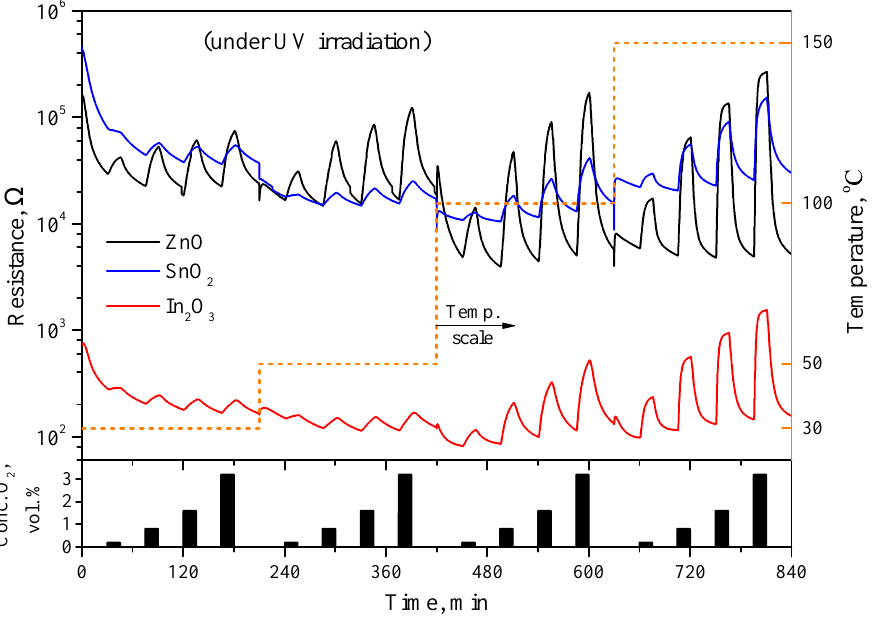
Figure 7. Electrical resistance of ZnO-, SnO 2 -, and In 2 O 3 -based sensors under continuous UV irradiation ( λ max = 365 nm) depending on the content of oxygen in gas phase in range of 0.2–3.2 vol.% at temperatures 30, 50, 100, and 150 ◦ C. Nitrogen was used as background